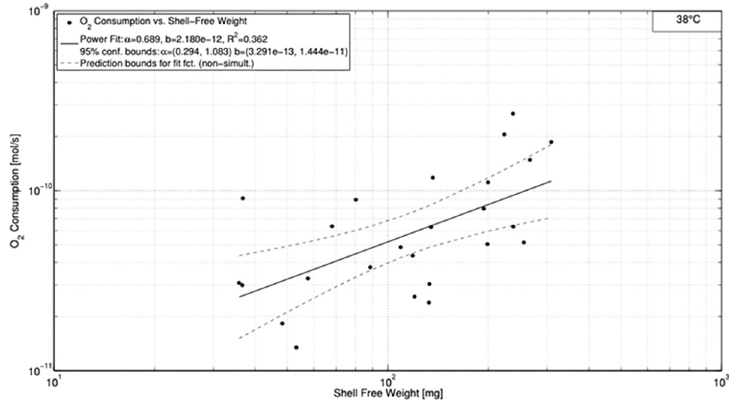
Fig 4. Oxygen consumption vs . shell free weight for 38˚C.